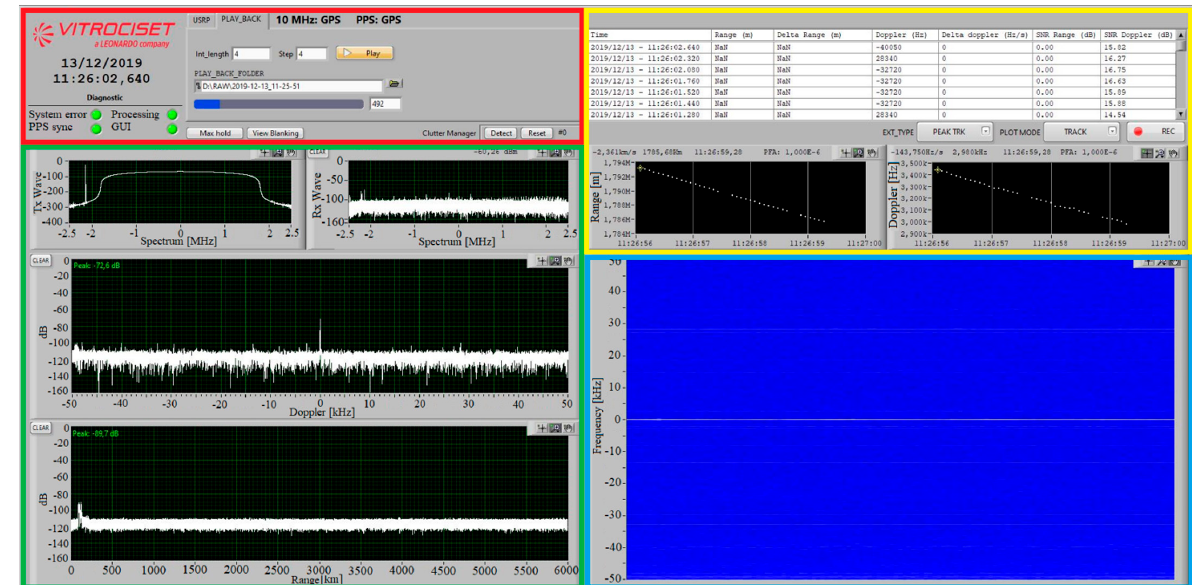
Figure 9. Screenshot of the Operator workstation Graphical User Interface (GUI). In detail, the control panel and status display (red block) allows two operating modes: USRP mode (data elaboration in real-time) and playback mode (data elaboration in post-processing). However, both operating modes save data in real-time. In addition, the epoch stamp and four diagnostic leds are available in the red block. These diagnostic leds indicate when there are system errors, the state of the data processing, the state of the 1PPS synchronization and the update state of the GUI plots. There are also available some functions for 2D plots, such as the max hold function and the view blanking function (which permits a graphical filtering of undesired signals).